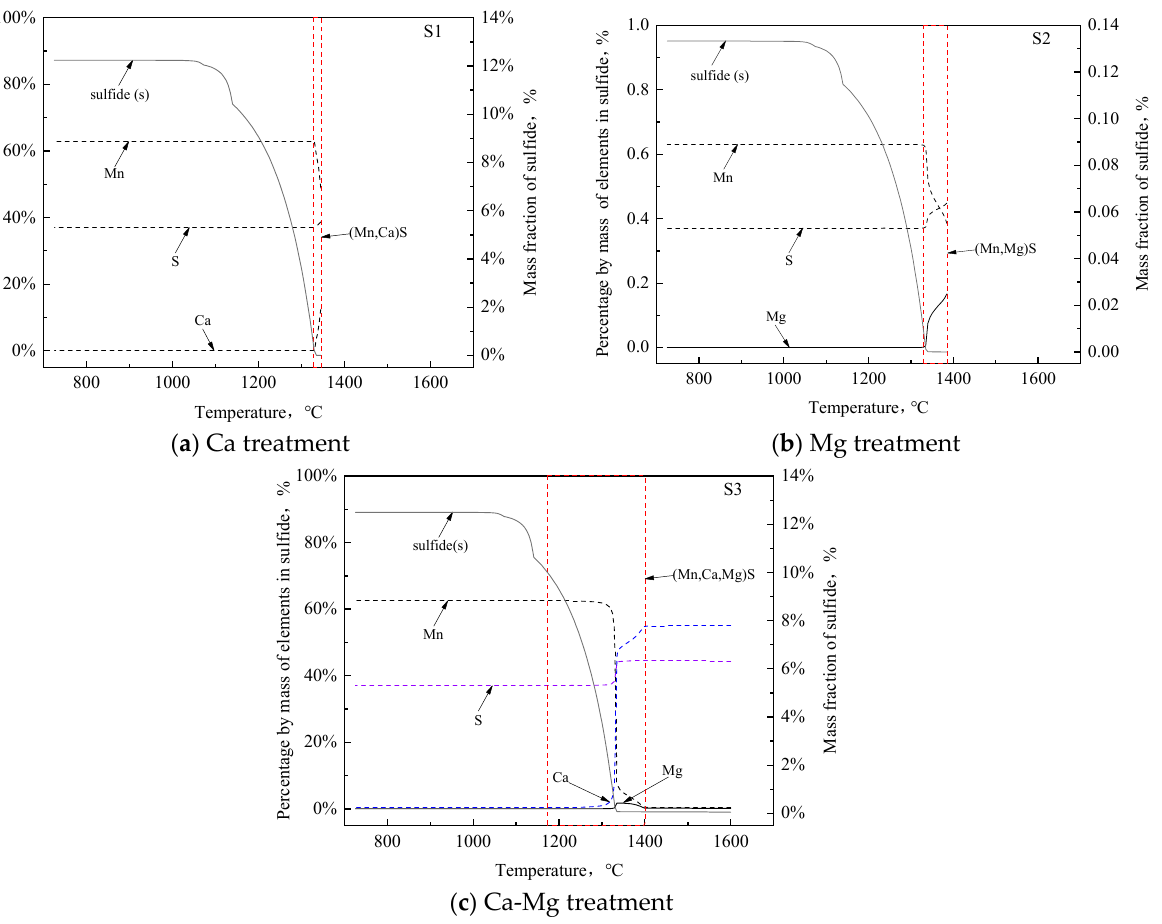
Figure 12. Temperature range for formation of complex sulfides.